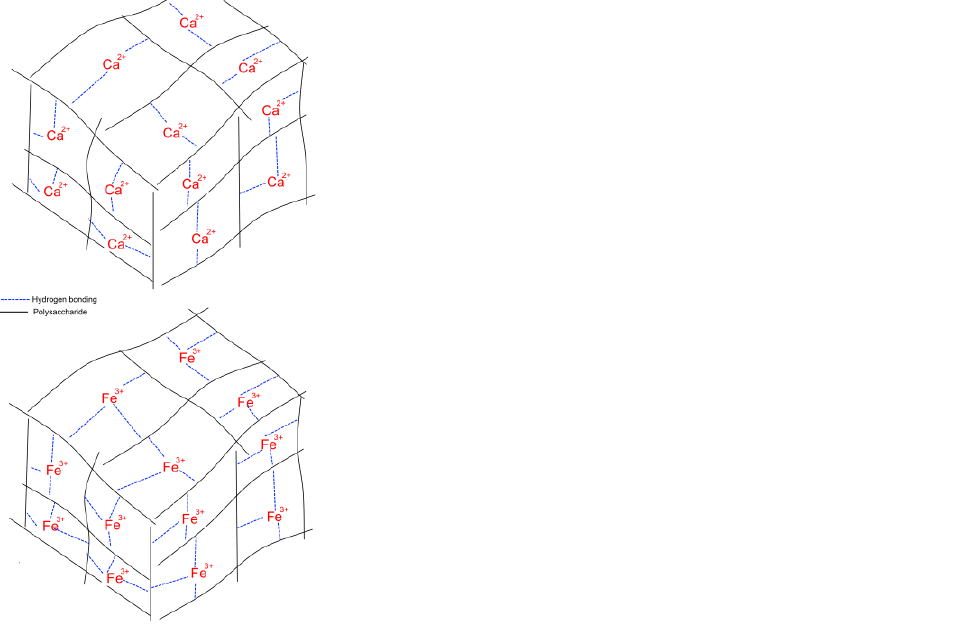
Figure 14. Mechanism presentation of the “egg-box” model of pectin gelation induced by Ca 2+ and Fe 3+ cations.